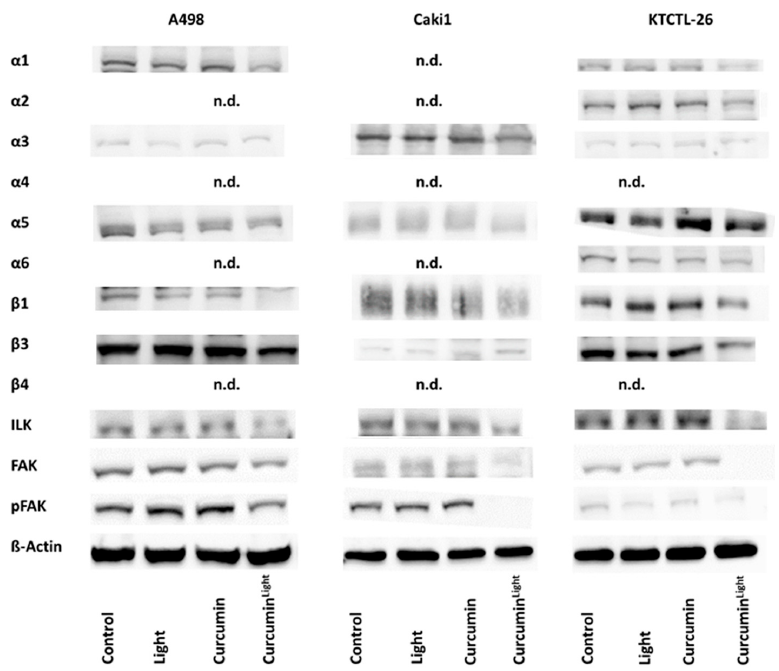
Figure 7. Western blot of α and β integrins, ILK and pFAK depending on the influence of curcumin (0.2 µg/mL), light, and curcumin Light on A498, Caki1, and KTCTL-26 cells. Protein levels were measured 24 h after respective treatments. All bands are representative of n = 3. β -actin served as loading control and is representatively shown once. 50 µg were used per sample. n.d. = not detectable.